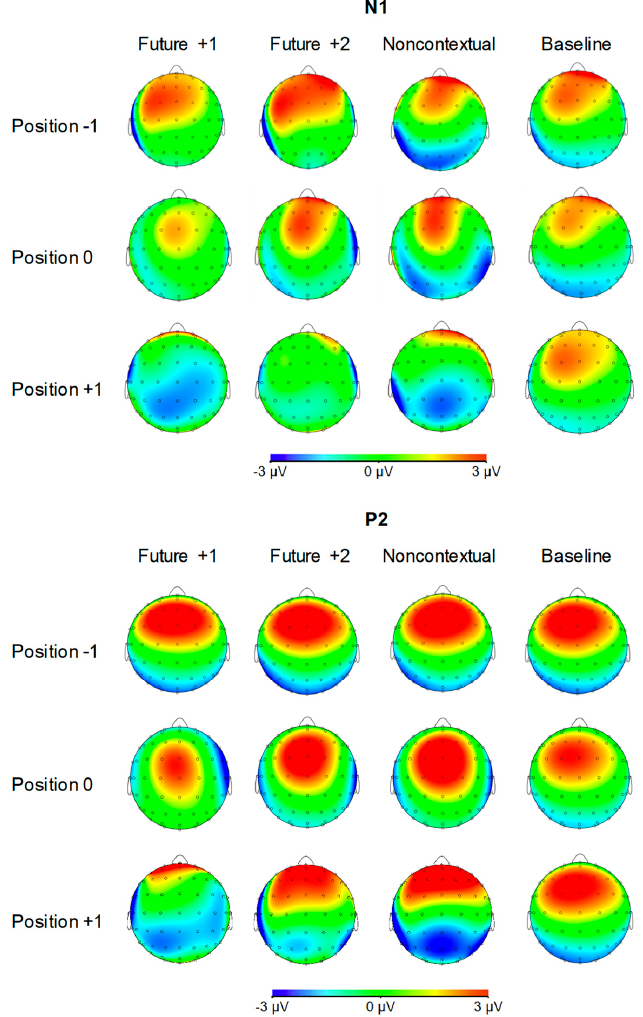
Figure 5. Voltage (in µ V) scalp topographies of N1 and P2 components relative to target event positions − 1, 0, and +1 by feedback condition. Activity averaged over 40 ms surrounding each component’s grand average peak is